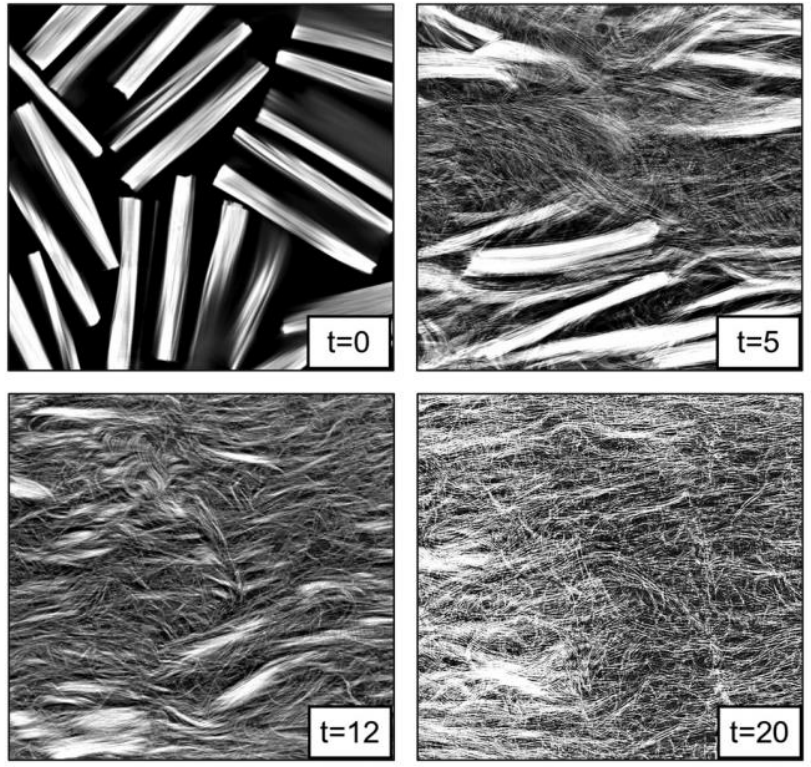
Figure 17. Micro-CT slices of fiber dispersion for PPGF40 (40 wt.% glass fiber-filled PP polymer) exposed to a simple shear flow at 50 s −1 for different residence times. Of note, the fiber diameter is 14 – 24 μm , and the density of fibers is 2.56 g/cm 3 [141].